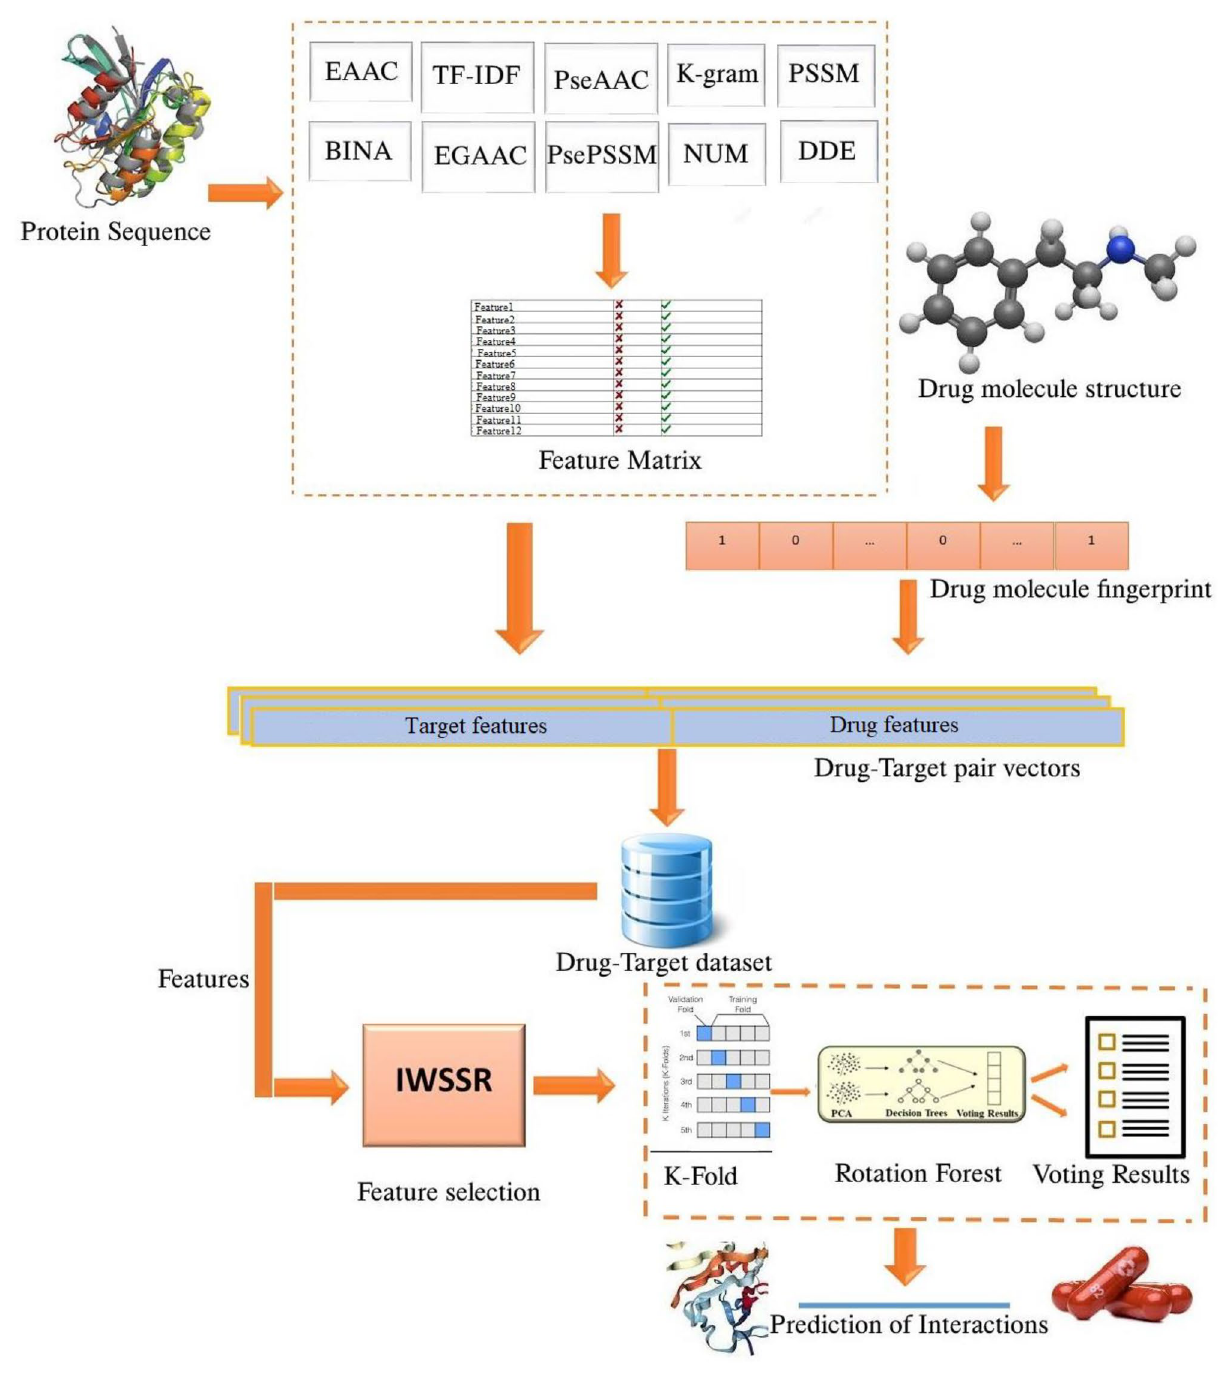
Figure 1. General steps of the proposed